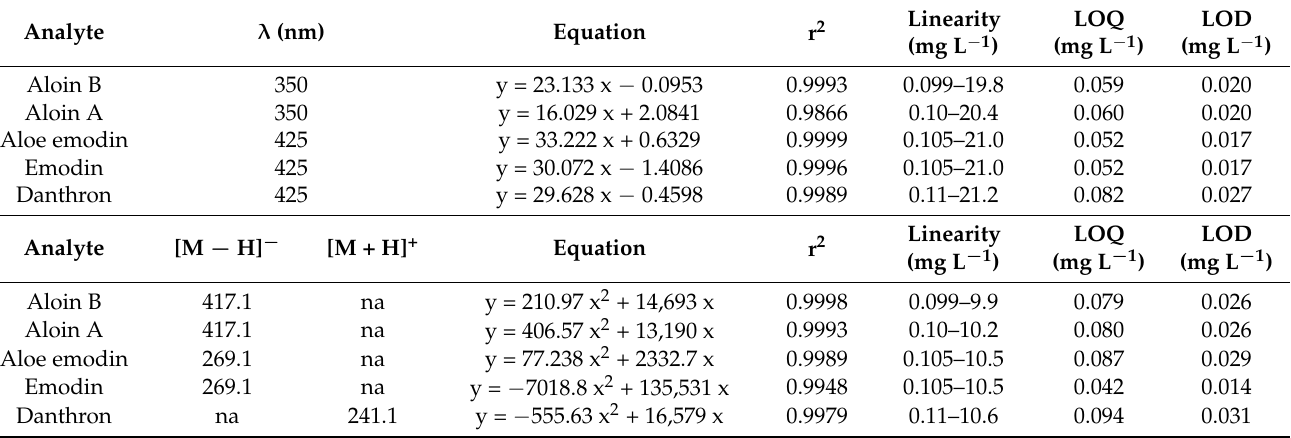
Table 1. Analytical characteristics of the proposed method for HAD standards obtained via LC–DAD and LC–MS ( n =